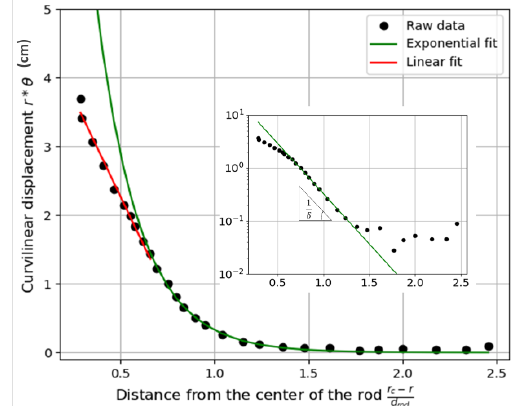
Fig. 7: Curvilinear displacement against distance from the center of the rod – graph in log space in the